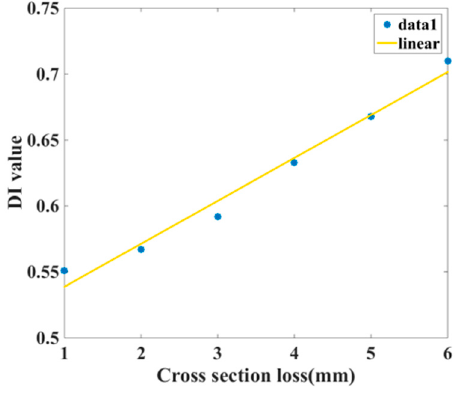
Figure 11. The DI evaluation of the reinforced concrete structures.